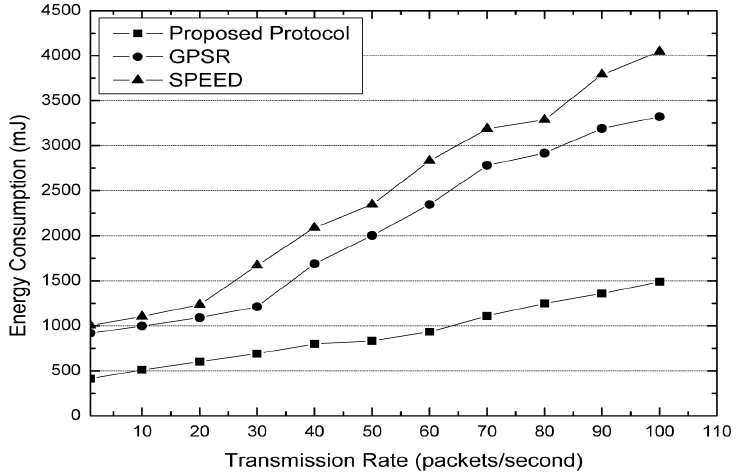
Figure 6. Energy consumption with different transmission rates.